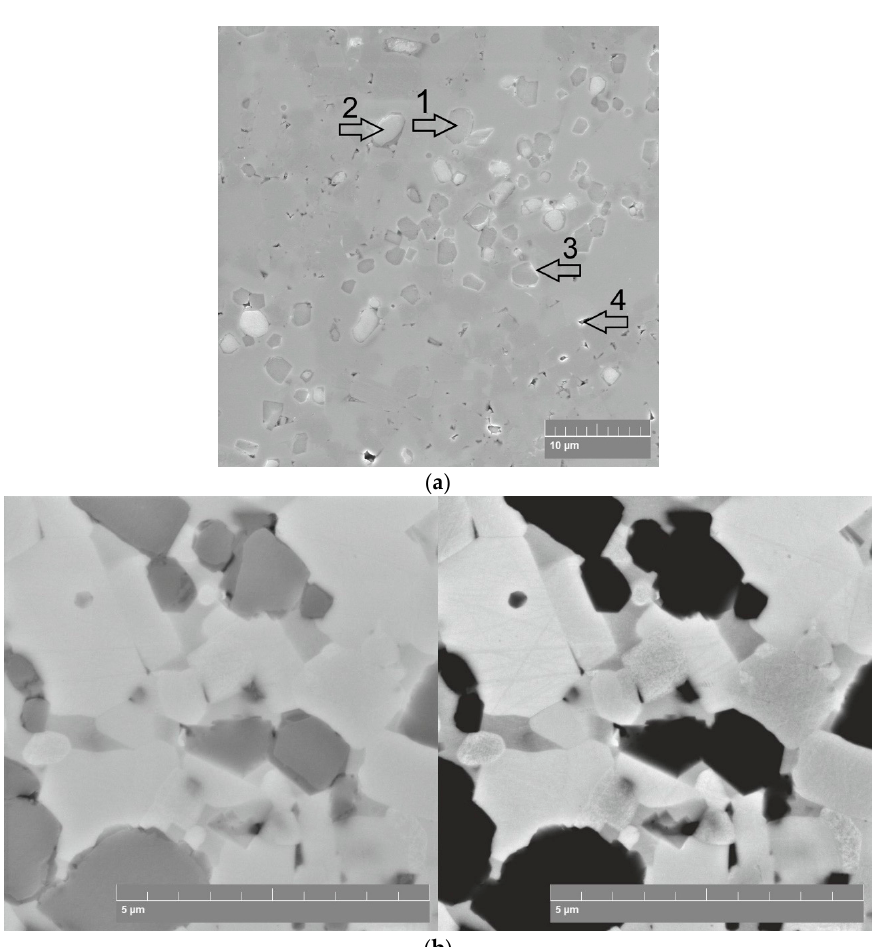
Figure 6. SEM micrographs of composite SPSed at 1400 °C: in-beam secondary electrons with magnification 5kx, arrow #1—dark phase, arrow #2—grey phase, arrow #3—bright phase and arrow #4—pore area ( a ) and comparison of in-beam secondary electrons and backscattered electrons micrographs ( b ).